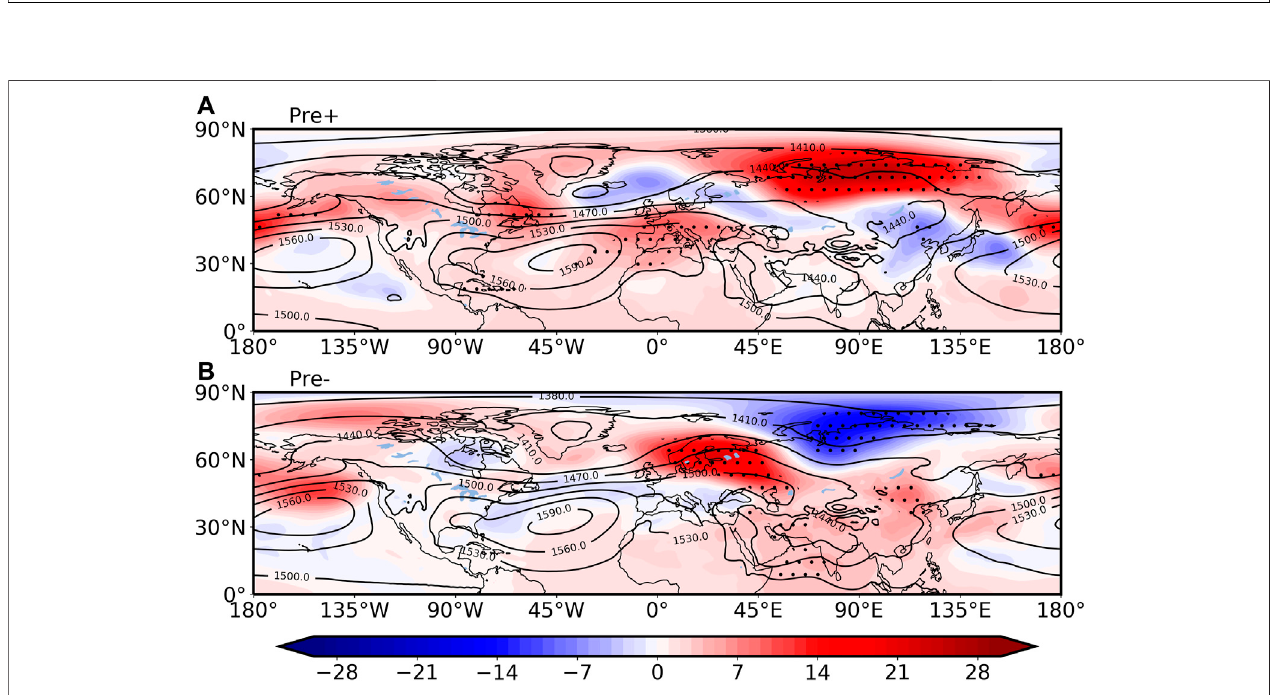
FIGURE 4 | Time series of summer precipitation anomalies (normalized) in the semi-arid regions of East Asia. The blue dots represent wet years, and the brown dots represent dry years.